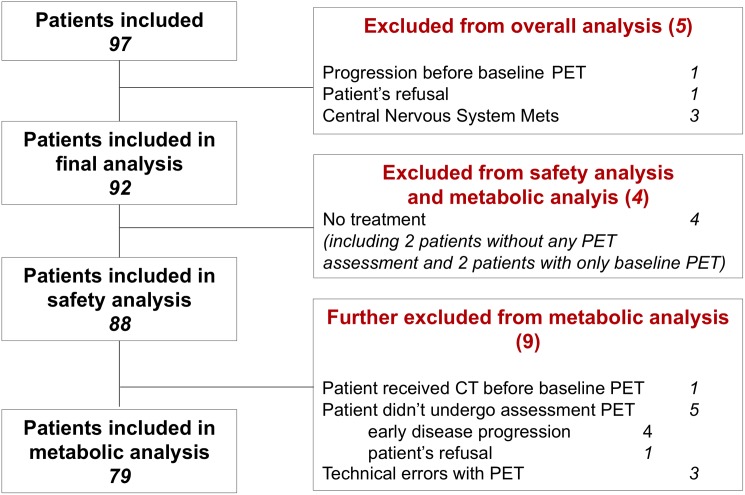
Consort Diagram.